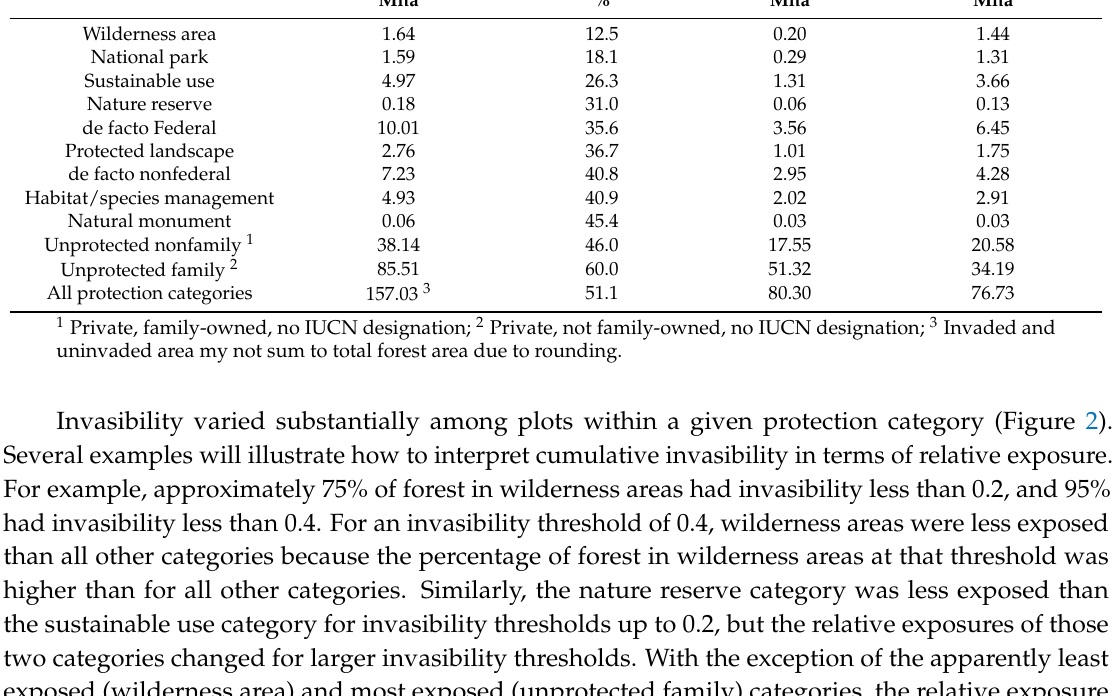
Table 3. Estimated exposure of forest area to invasive species. Categories are sorted by the proportion of total area invaded.